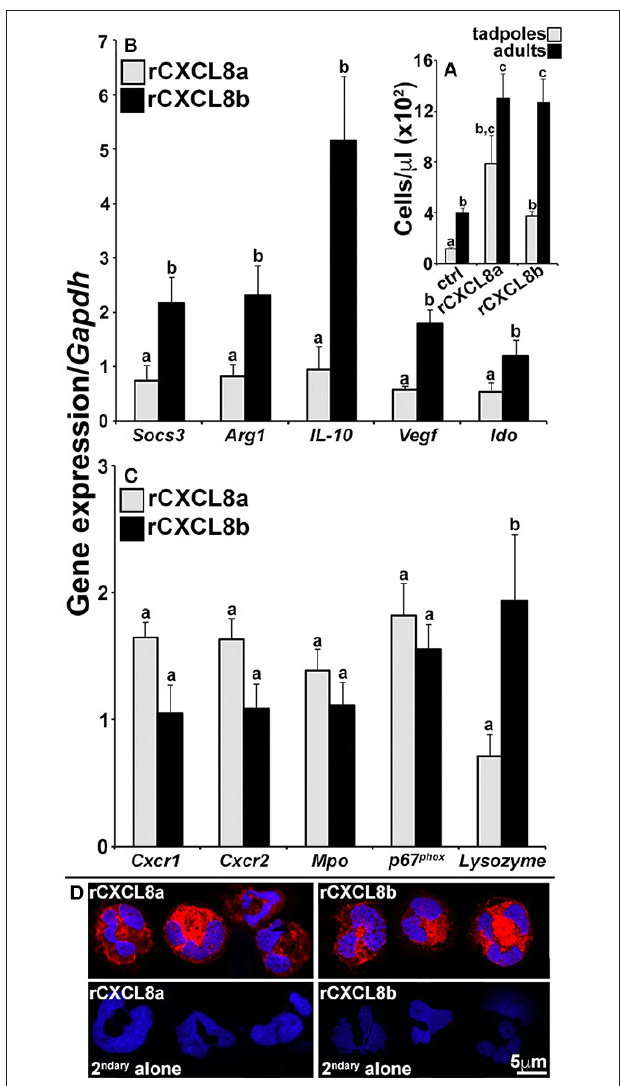
FIGURE 6 | Analysis of immune gene expression and cytology of rCXCL8a- and rCXCL8b-elicited tadpole cells . Tadpoles and adult frogs were injected intraperitoneally with rCXCL8a or rCXCL8b (1 µ g/g of body weight) in 10 µ l of saline or with an equal volume of the vector control (supernatants from empty vector-transfected Sf9II cell, processed in parallel to rCXCL8a and rCXCL8b production). After 4h, animals were lavaged with saline and the cells were enumerated (A) . The tadpole (B,C) and adult frog (not presented) rCXCL8a and rCXCL8b-elicited cell immune gene expression was examined relative to the Gapdh control ( N = 6). All results are presented as means + SEM. Above-head letters denote statistical designations: experimental groups described by distinct letters are statistically different ( P < 0.05) while those marked by the same letters are not. (D) Tadpole rCXCL8a and rCXCL8b-elicited cells were stained with a rabbit anti-frog rG-CSFR (or saline) Ab and secondary goat anti-rabbit Ab and examined by confocal microscopy.